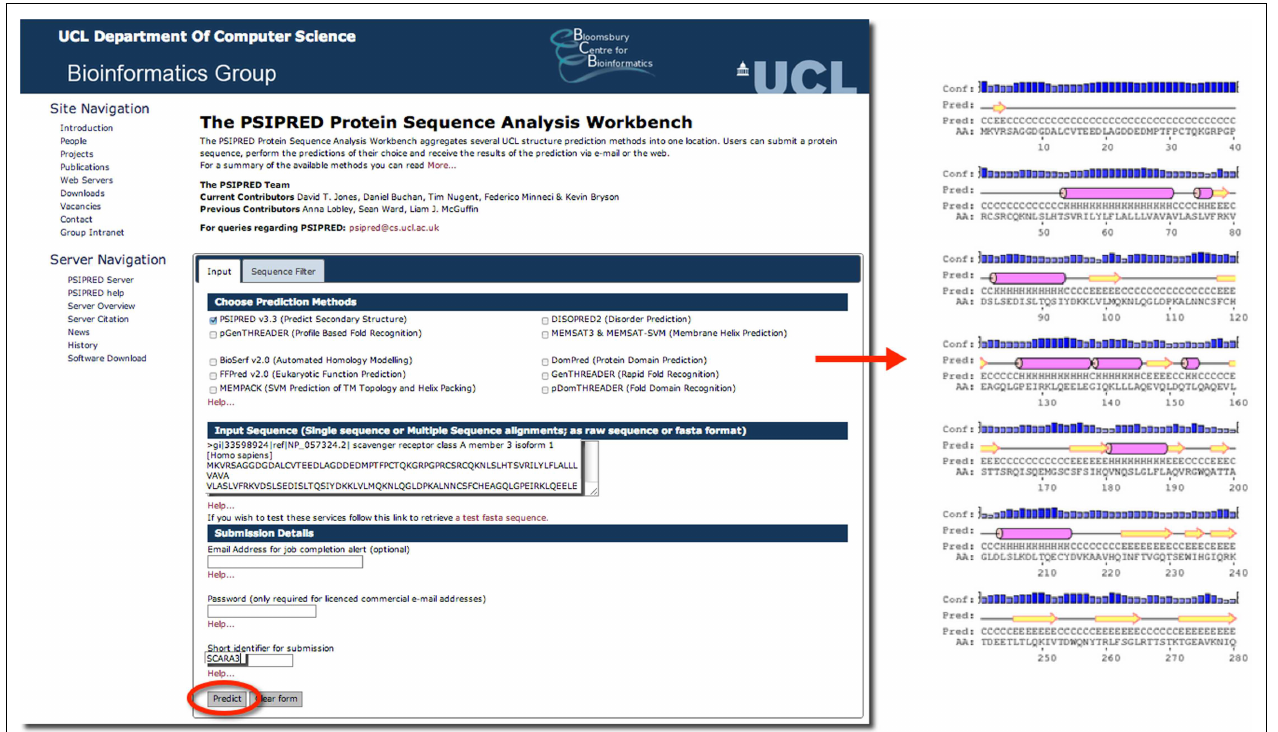
protein sequence of SCARA3, Psipred outputted structural predictions, including the location of α -helices (pink cylinders) and β -sheets (yellow